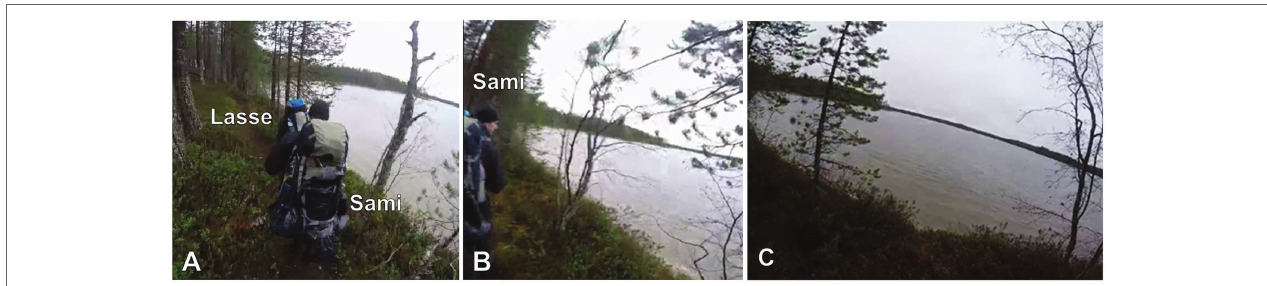
FIGURE 3 | Lasse and Sami walk along a lakeside path; the head-mounted camera worn by Janne is directed toward them (A) . Sami looks at the lakeside; the head-mounted camera worn by Janne turns toward the lake (B) . The head-mounted camera worn by Janne is directed toward the lake(side) (C)